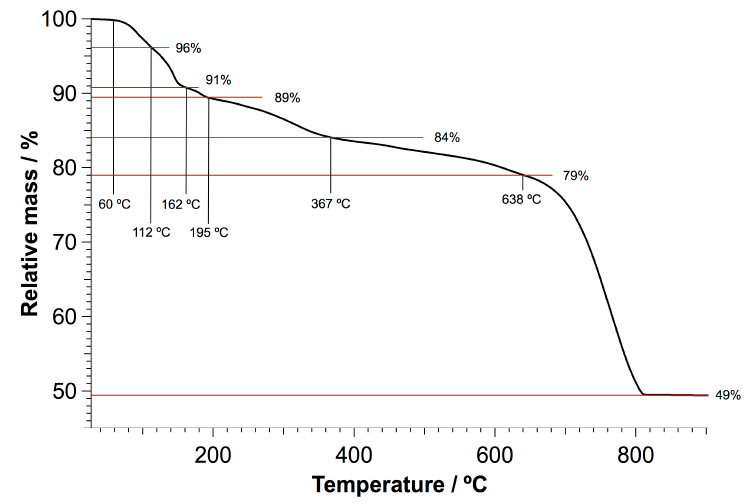
Figure 4. Thermal gravimetric analysis of the urinary stone of a guinea pig.